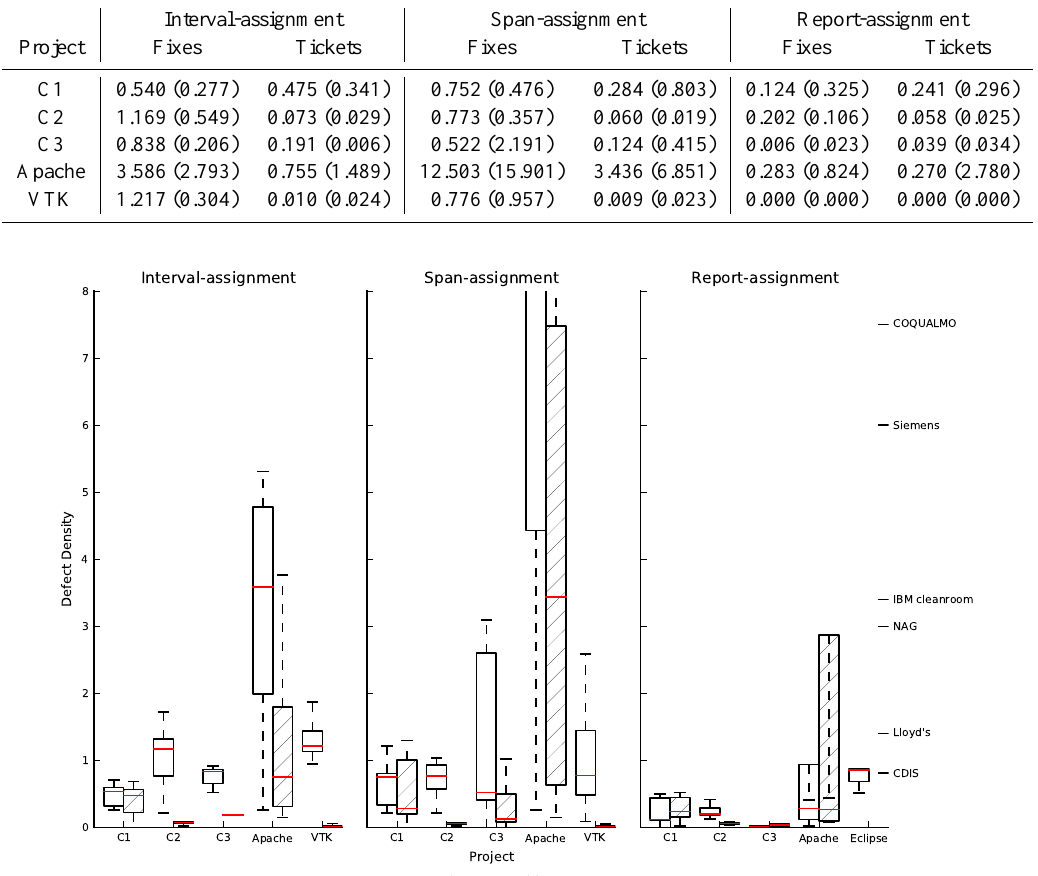
Table 2. Median project defect density (interquartile range in parenthesis) of analysed versions under different defect assignment methods. Interval-assignment